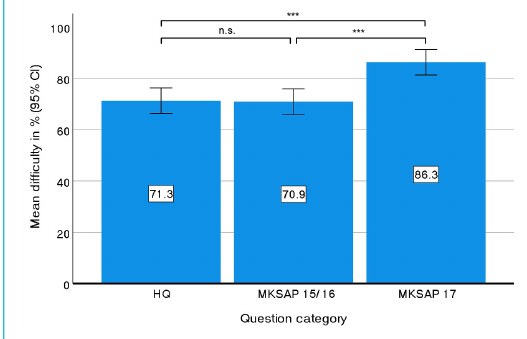
Figure 1: Average item difficulty of Helvetic, MKSAP-15/16 and MKSAP-17 questions. Comparison of question difficulty (lower lev- els indicate higher degree of difficulty) of questions from different sources in the November 2019 board examination. HQ and MK- SAP-15/16 questions were much more difficult to answer than MK- SAP-17 questions. *** p <0.001. Error bars denote the 95% confi- dence intervals of the